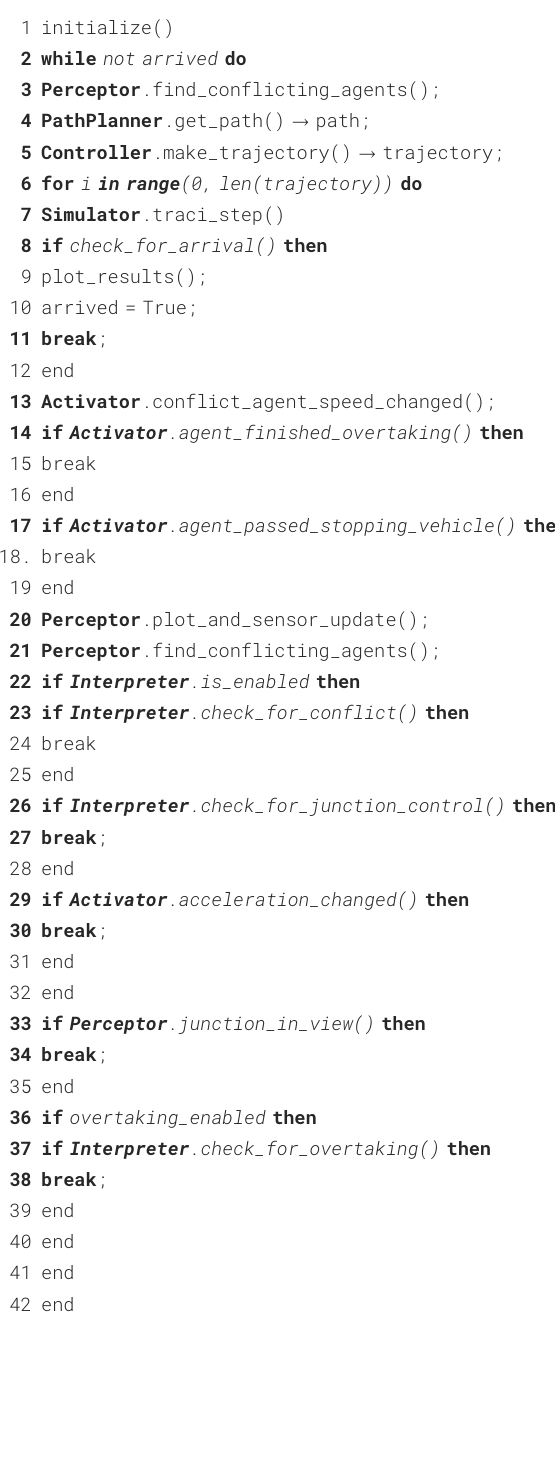
Algorithm 1. The main control loop of the autonomous agent.